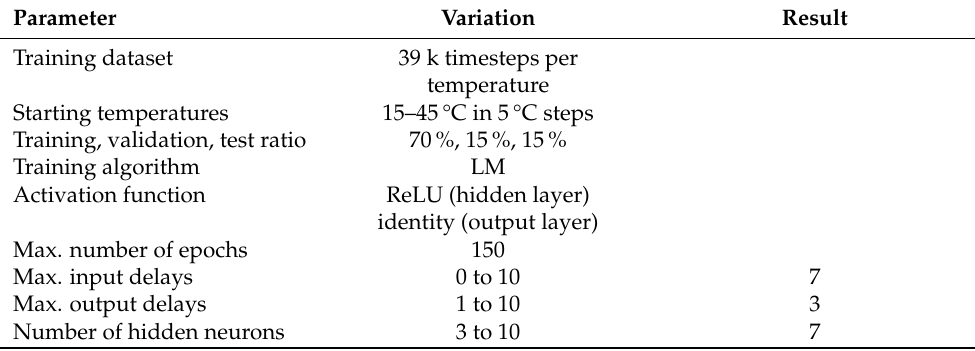
Table 2. Parameters for the neural network applied as thermal